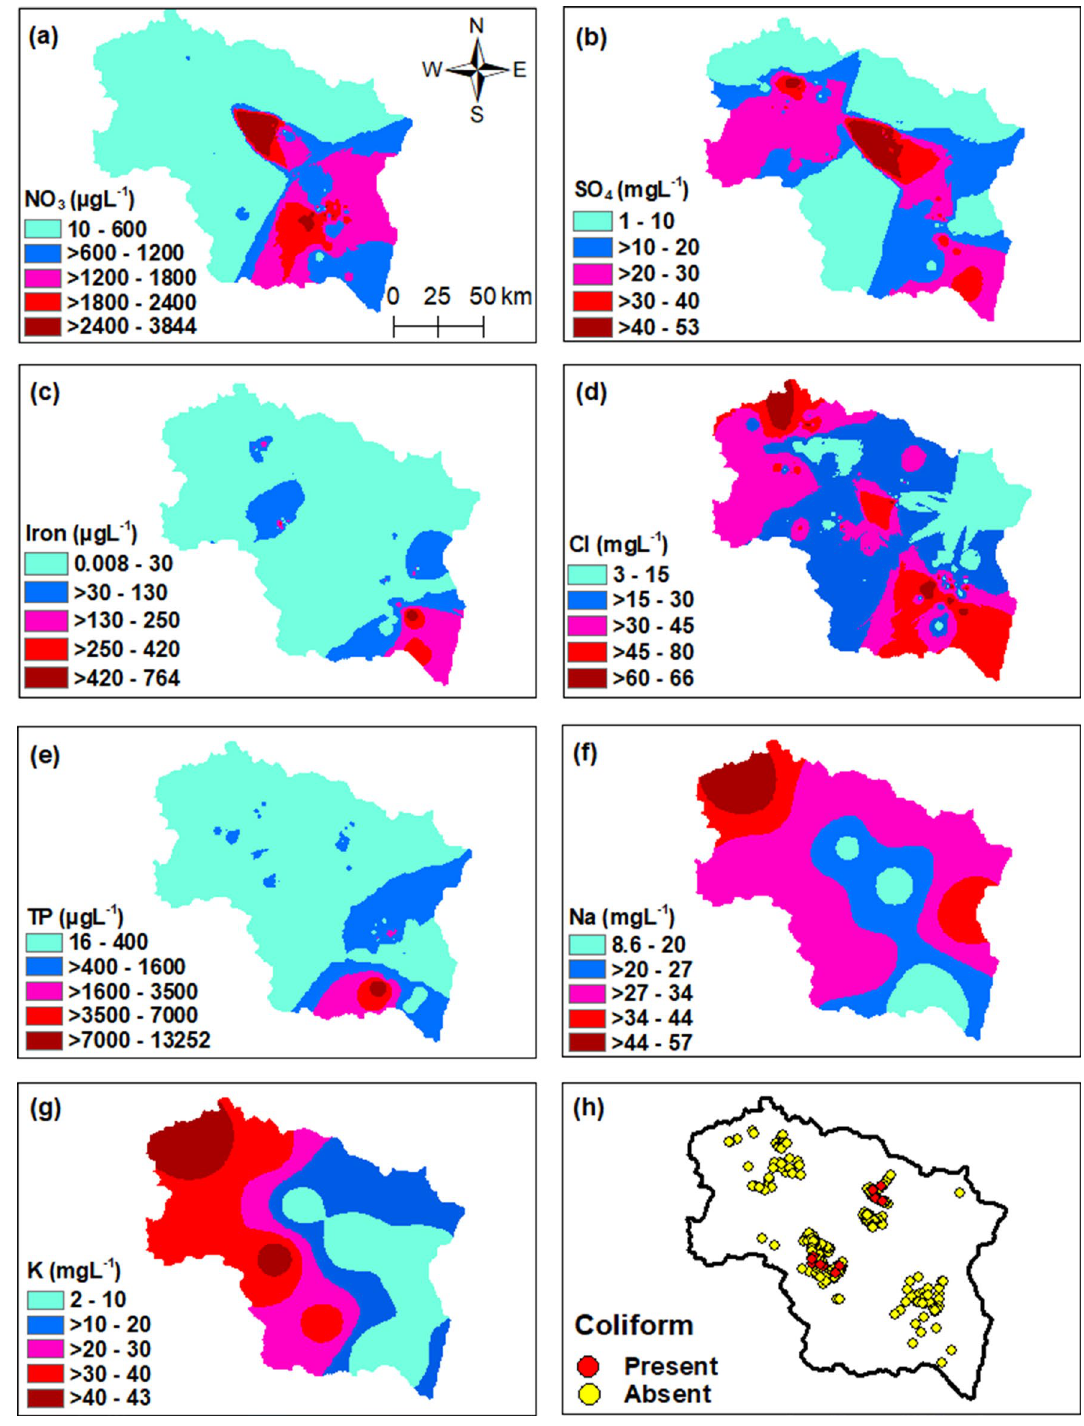
Figure 2. Spatial distribution of ( a ) nitrate (µg L −1 ), ( b ) sulphate (mg L −1 ), ( c ) iron (µg L −1 ), ( d ) chloride (mg L −1 ), ( e ) total phosphorus (µg L −1 ), ( f ) sodium (mg L −1 ), ( g ) potassium (mg L −1 ), and ( h ) coliform of freshwater springs in Kashmir valley. The figure was generated using spatial analyst module and Natural Neighbor interpolation in ArcGIS version 10.4.1. (https:// www. esri. com/ en- us/ arcgis/ produ cts/ arcgis-